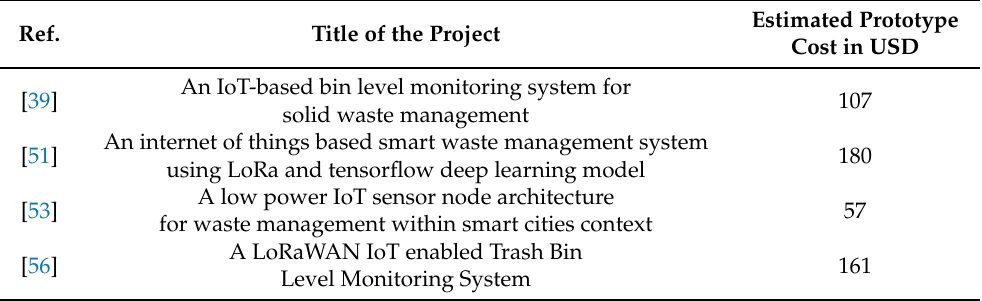
Table 7. Estimated cost comparison of IoT-based approaches.